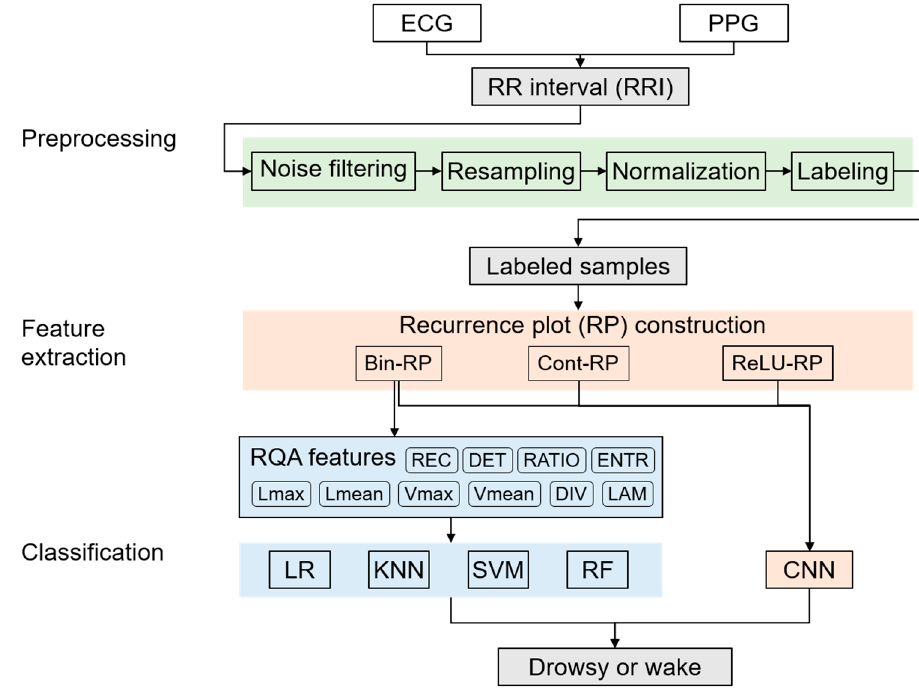
Figure 1. Overall